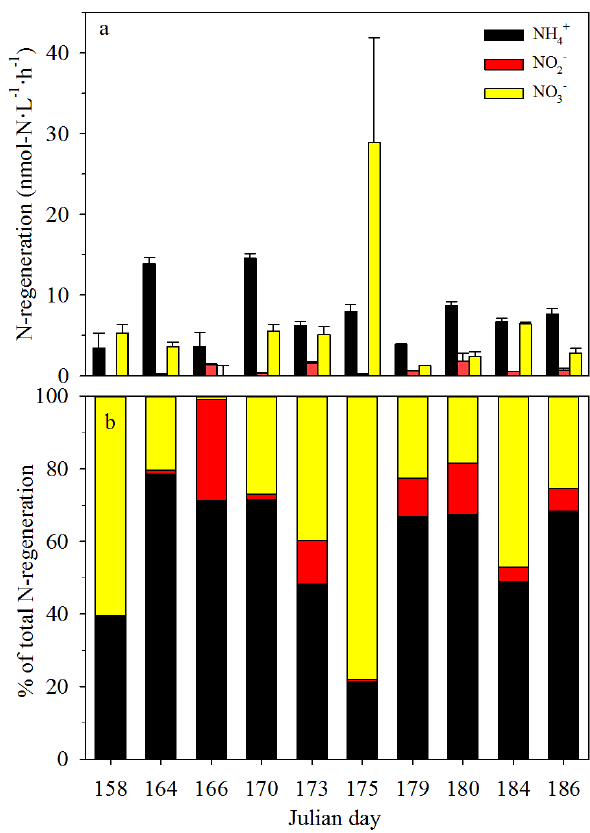
Figure 5. The rate of NH + termined at observational stations identified in Fig. 1, and the con- tribution (in %) that each inorganic nitrogen source makes to total N-regeneration (b)